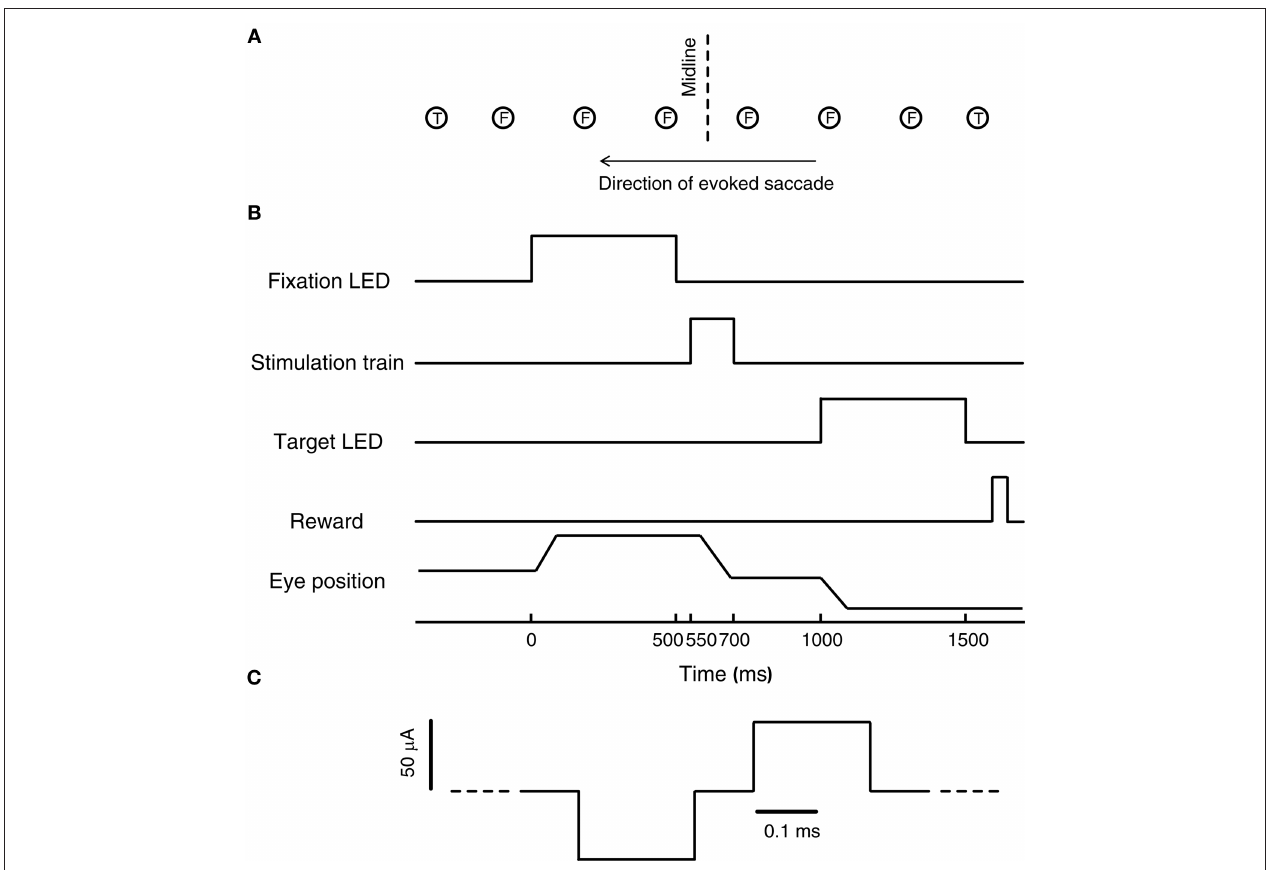
FIgure 1 | experimental design. (A) Schematic of the stimulus array. Six evenly spaced fixation LEDs (F, between − 15 ° and 15 ° ), were aligned approximately along the axis of the evoked saccades. Two target LEDs (T) were located to the left and right of the array of fixation LEDs, along the same